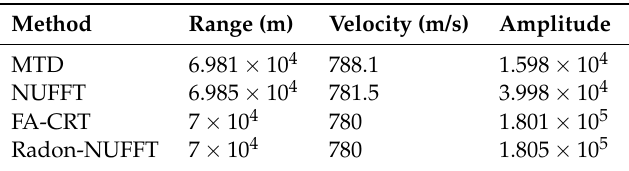
Table 2. Location and value of the maximum peak